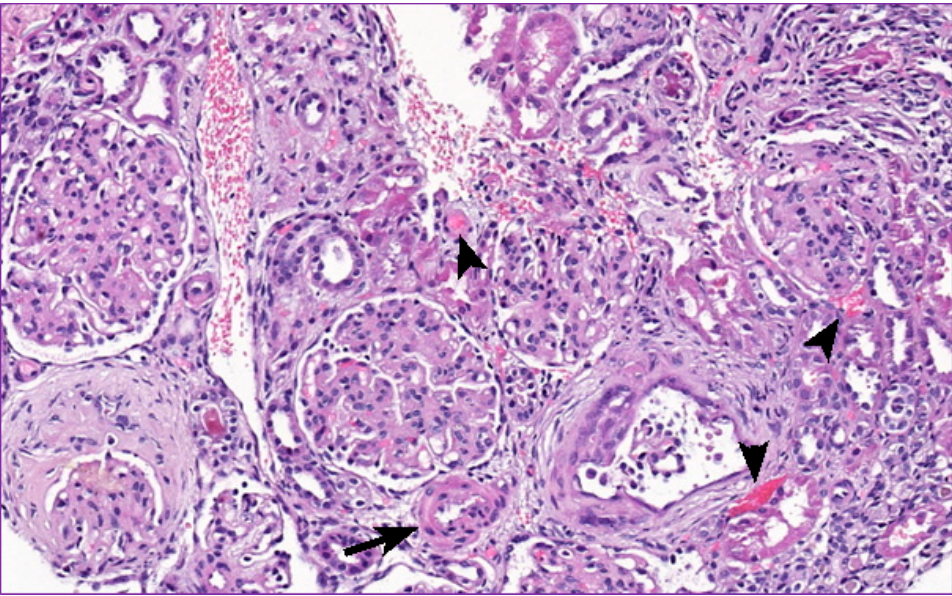
Figure 3. Increased cellularity of the glomeruli, accompanied by extracellular matrix expansion. Small thrombi located in the interstitium (arrowheads). Small arteriole with a thick wall (arrow).